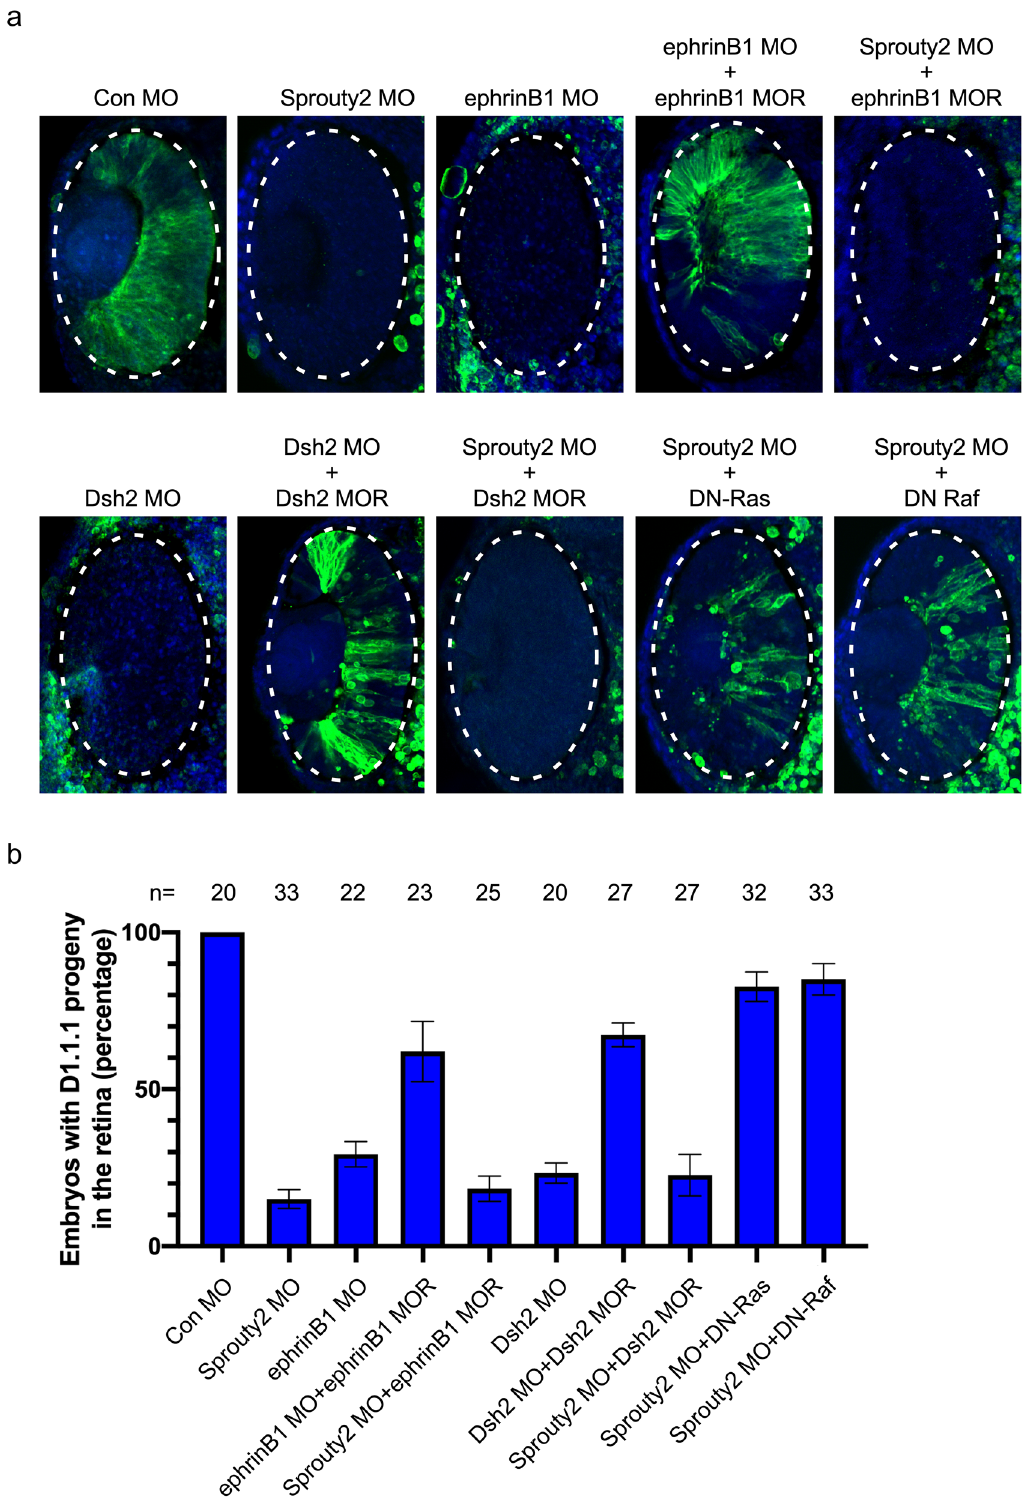
Figure 2. Blocking of Ras/Raf/MAPK pathway rescues Sprouty2 MO-induced block to retina population. ( a ) Indicated morpholinos or RNAs were injected with GFP RNA into D1.1.1 blastomere at 32 cell stage. Embryos were then sectioned and immunostained with GFP antibody (Green) at stage 33. Images were taken of the eye region. The retina was outlined with an oval dotted line. ( b ) Histograms represent the percentage of embryos with D1.1.1 progeny (GFP positive signal) within the retina from three biological repeats. Quantification with one-way ANOVA (Sidak’s multiple comparison), P < 0.0001, Error bars indicate ±